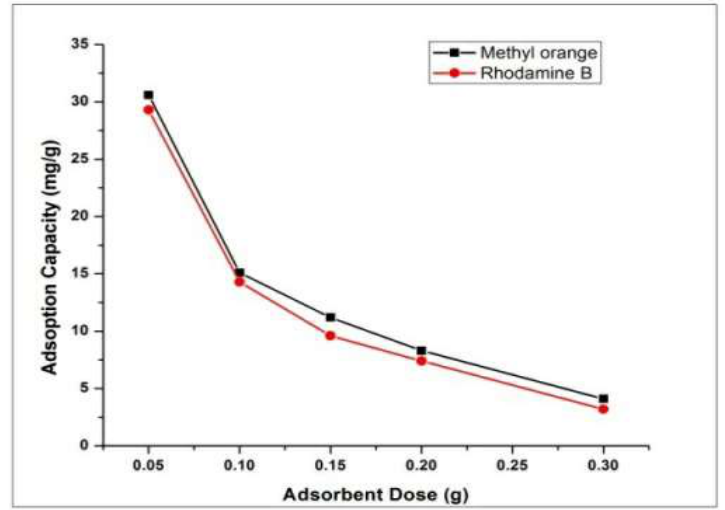
Figure 14. Effect of adsorbent dose on dyes adsorption.